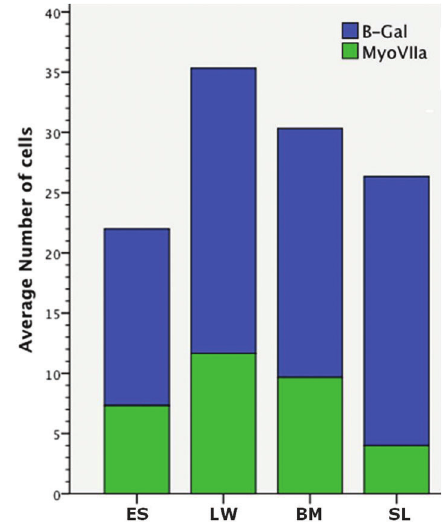
Figure 4. Average number of transplanted mIESsC expressing b -gal and the number of cells expressing b -gal + myosin VIIa in various areas of the scala media. ES: endolymphatic space; LW: lateral wall; BM: basilar membrane; SL: spiral